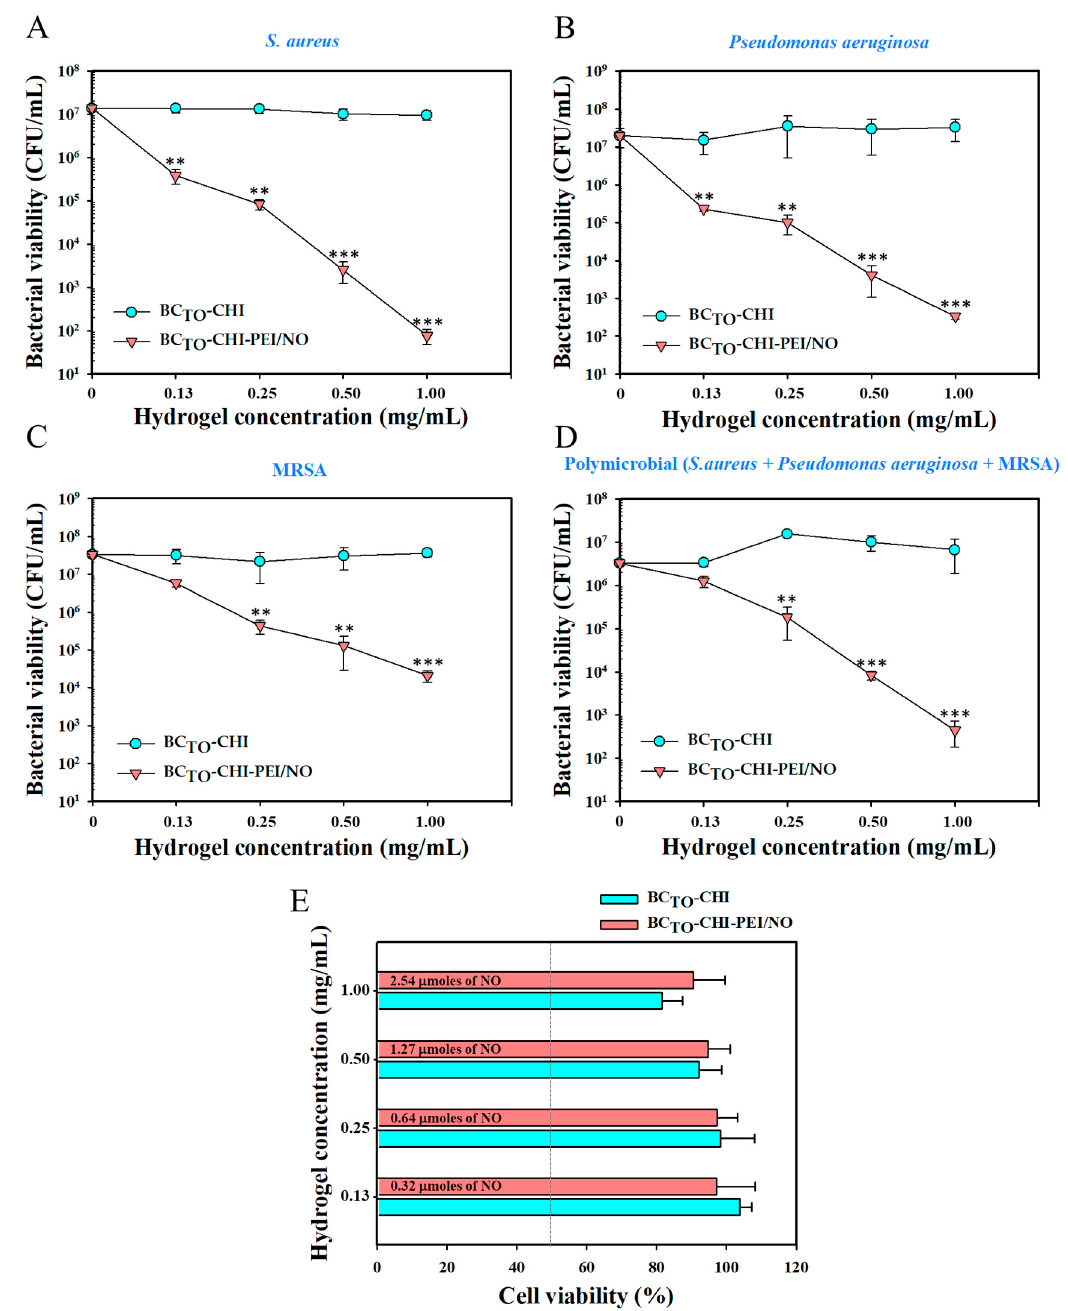
Figure 6. Antibacterial activity of BC TO -CHI and BC TO -CHI-PEI/NO against ( A ) S. aureus, ( B ) Pseudomonas aeruginosa, ( C ) MRSA, and ( D ) polymicrobial infection. Data are presented as the mean ± standard deviation; n = 3. “**” and “***” indicate p < 0.01 and p < 0.001 compared to the BC TO -CHI, respectively. Viability (%) of L929 mouse fibroblast cells following 24 h of exposure to various concentrations of NPs ( n = 8) ( E ).